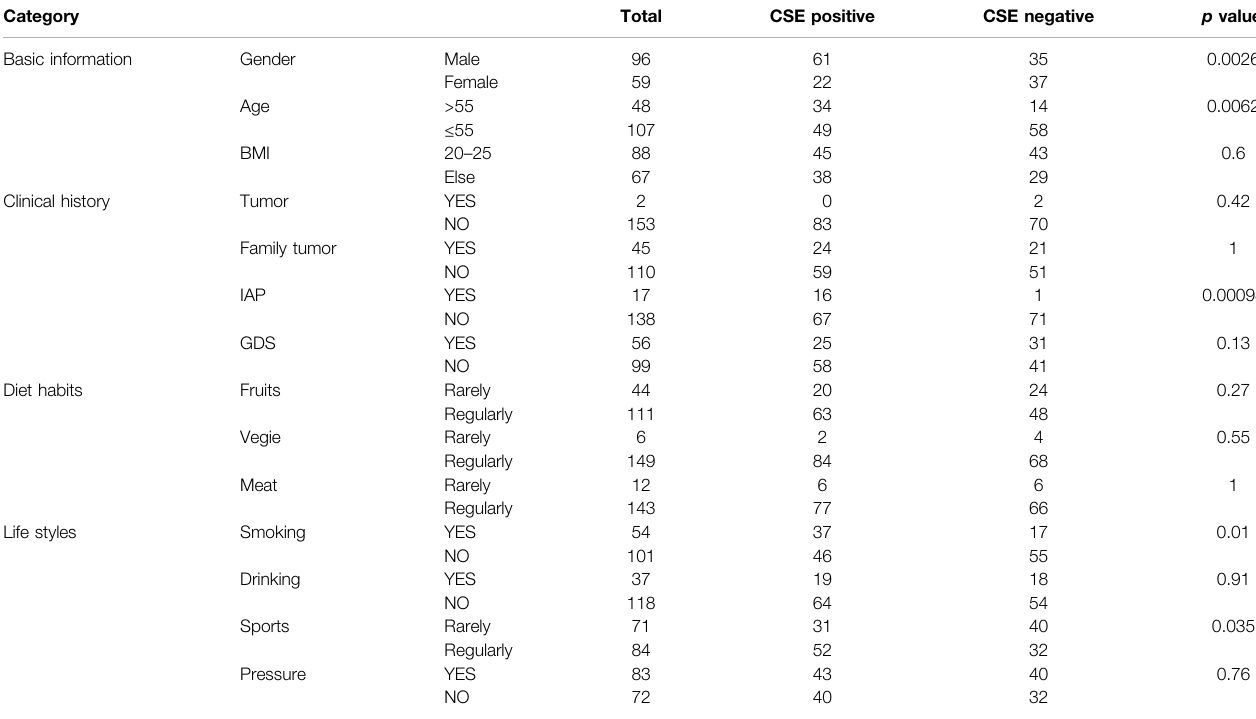
TABLE 1 | Features of FIT positive participants and their correlation with colorectal